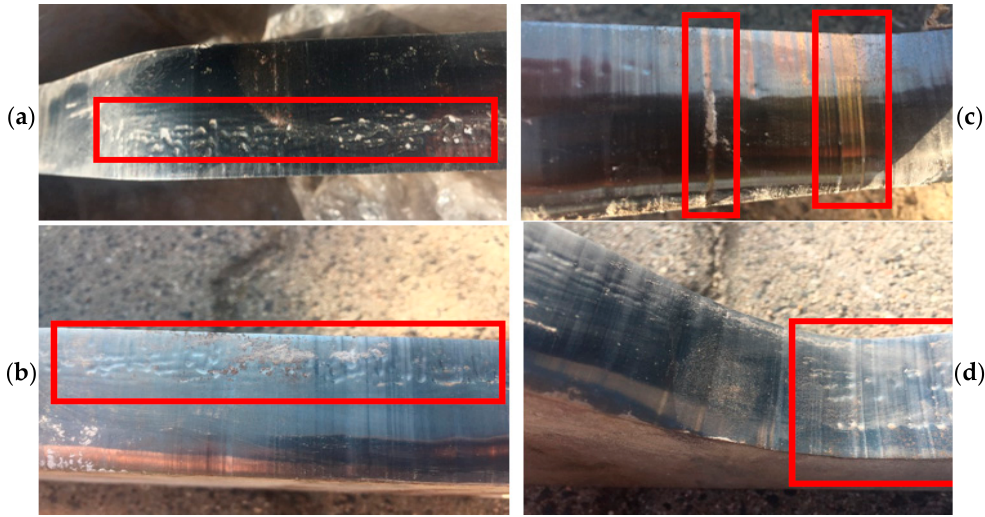
Figure 4. Macroscopic analysis of selected inserts forming the clay band: ( a ) visible traces of imprints; ( b ) scratches and cracks; ( c ) perpendicular scratches; ( d ) plastic deformations.